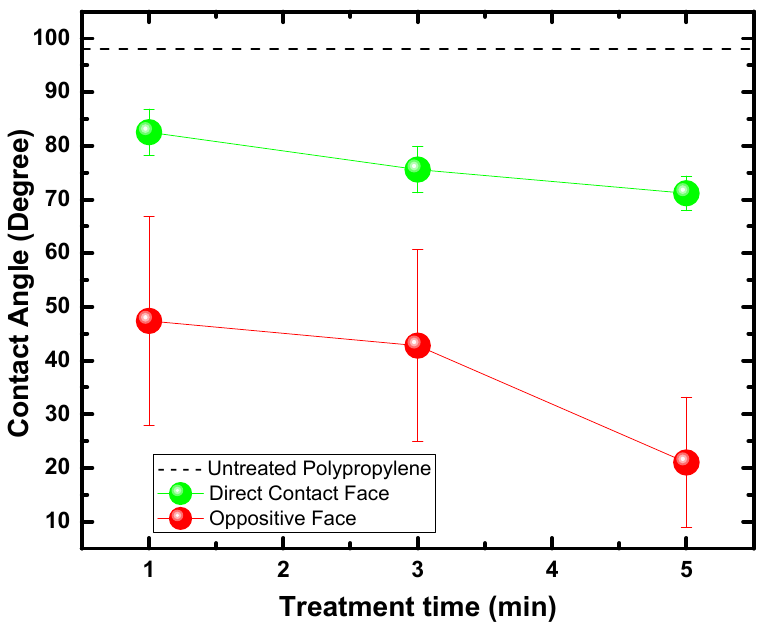
Figure 3. Mean values of water contact angle of polypropylene samples measured on DCF with plasma and OF for 1.0, 3.0, and 5.0 min of treatment.